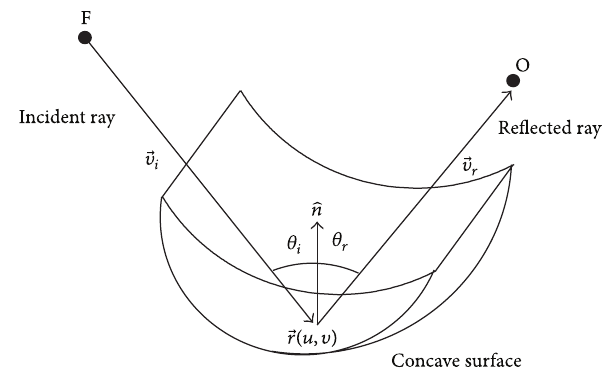
Figure 2: Simple reflection on a concave